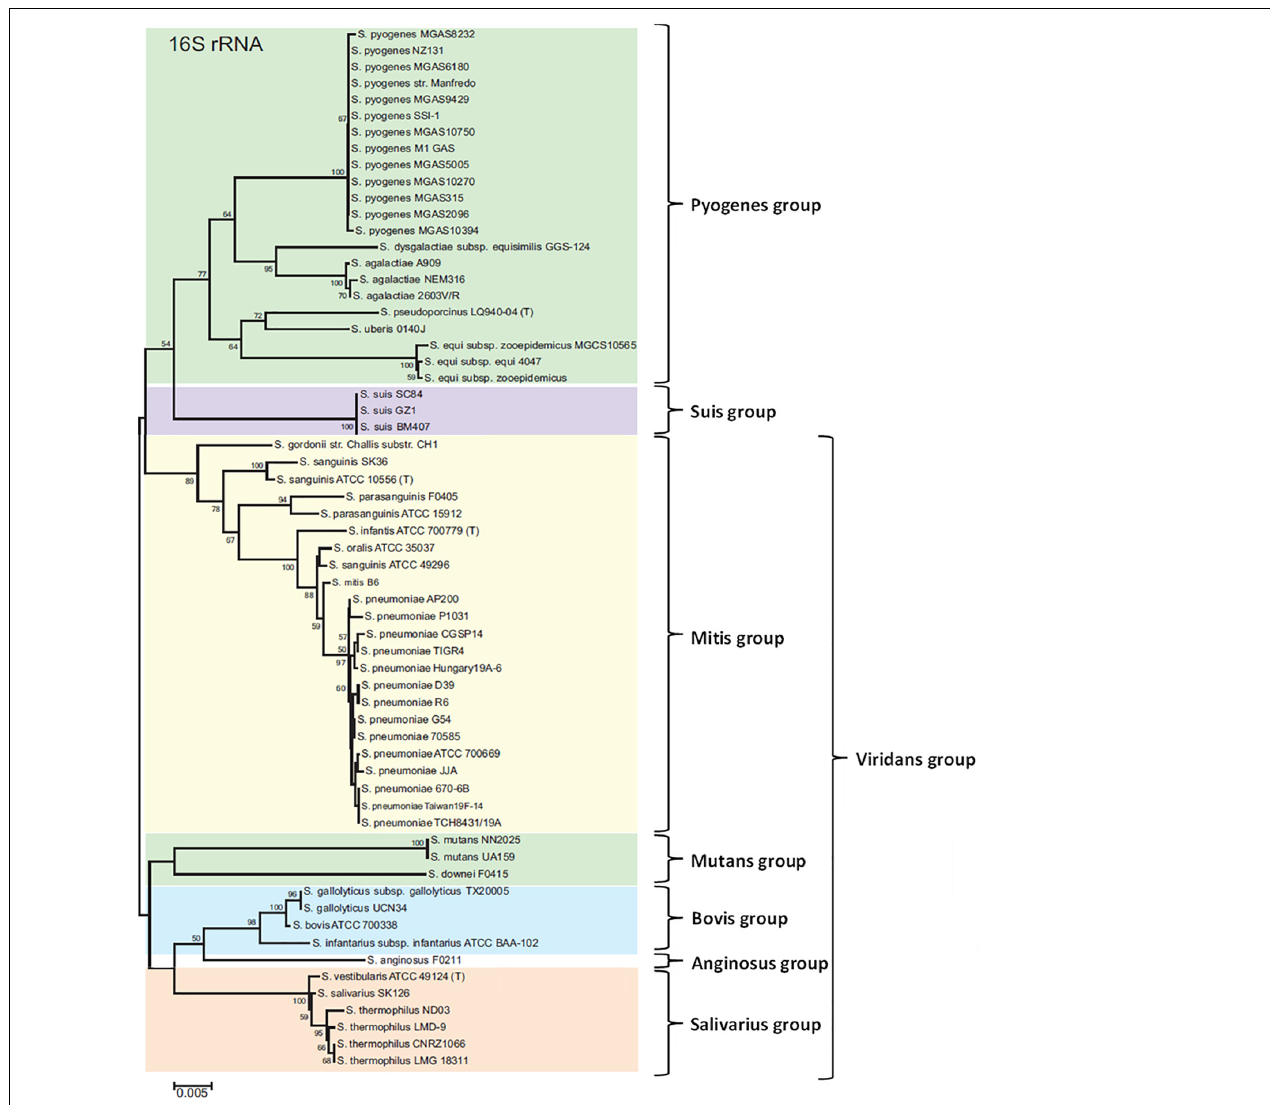
FIGURE 1 | Seven groups formed from a neighbor-joining tree based on 16S rRNA gene sequences of Streptococcus . The numbers at the nodes indicate the values of bootstrap statistics after 2,000 replications, and values below 50% are not shown. Bars at 0.005% estimated sequence divergence. Adapted from Thompson et al.